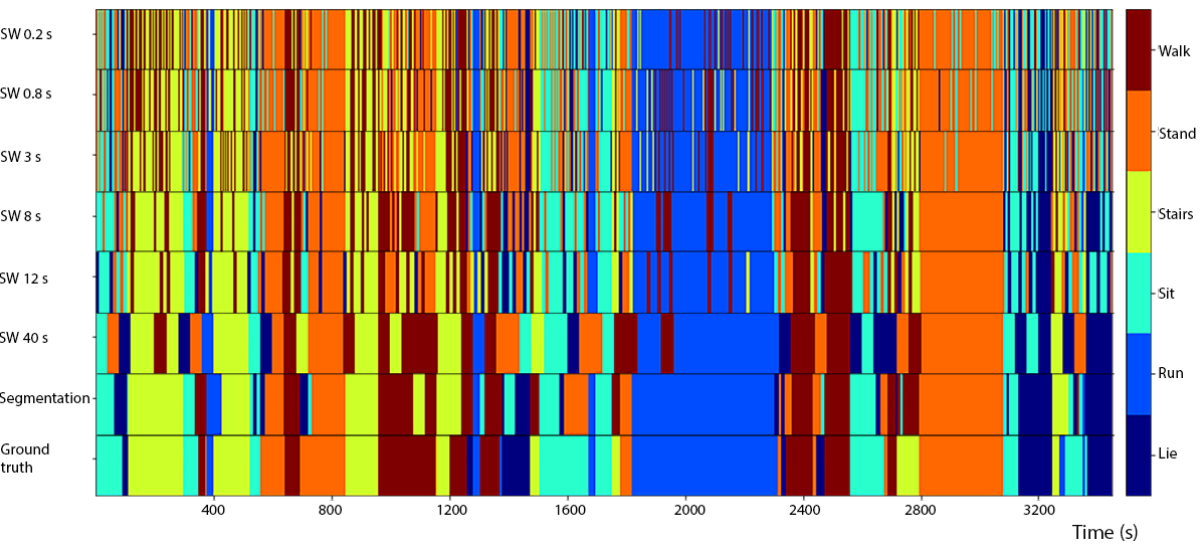
Figure 15. Predictions from Xgboost using 6 different fixed-sized sliding windows (SWs) and greedy Gaussian segmentation as well as the ground